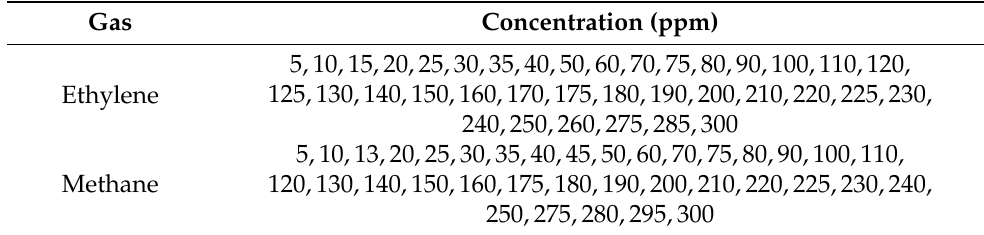
Table 4. Data set concentration information